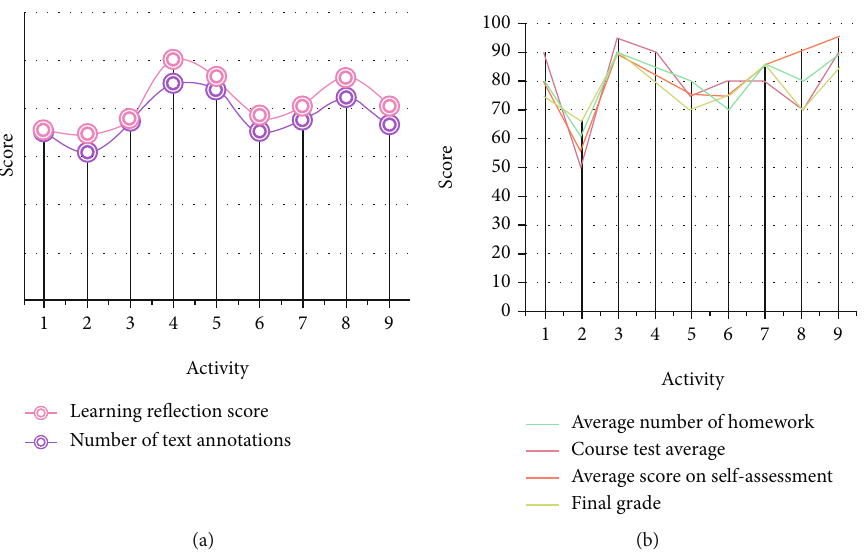
Figure 6: Visualization results of student content